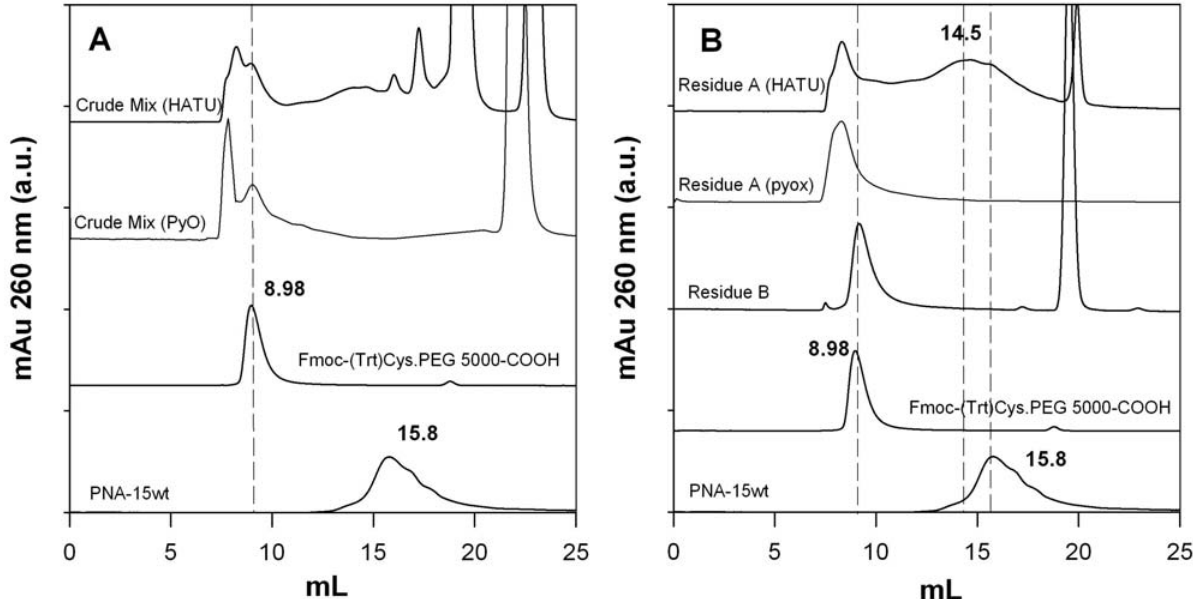
Figure 3. Gel permeation chromatography of crude reaction mixtures ( A ) and residues A and B ( B ) obtained with the HATU/DMAP and PyOxim/TEA coupling reagents. The elution profiles of non modified PNA and the PEO reagent are also shown for